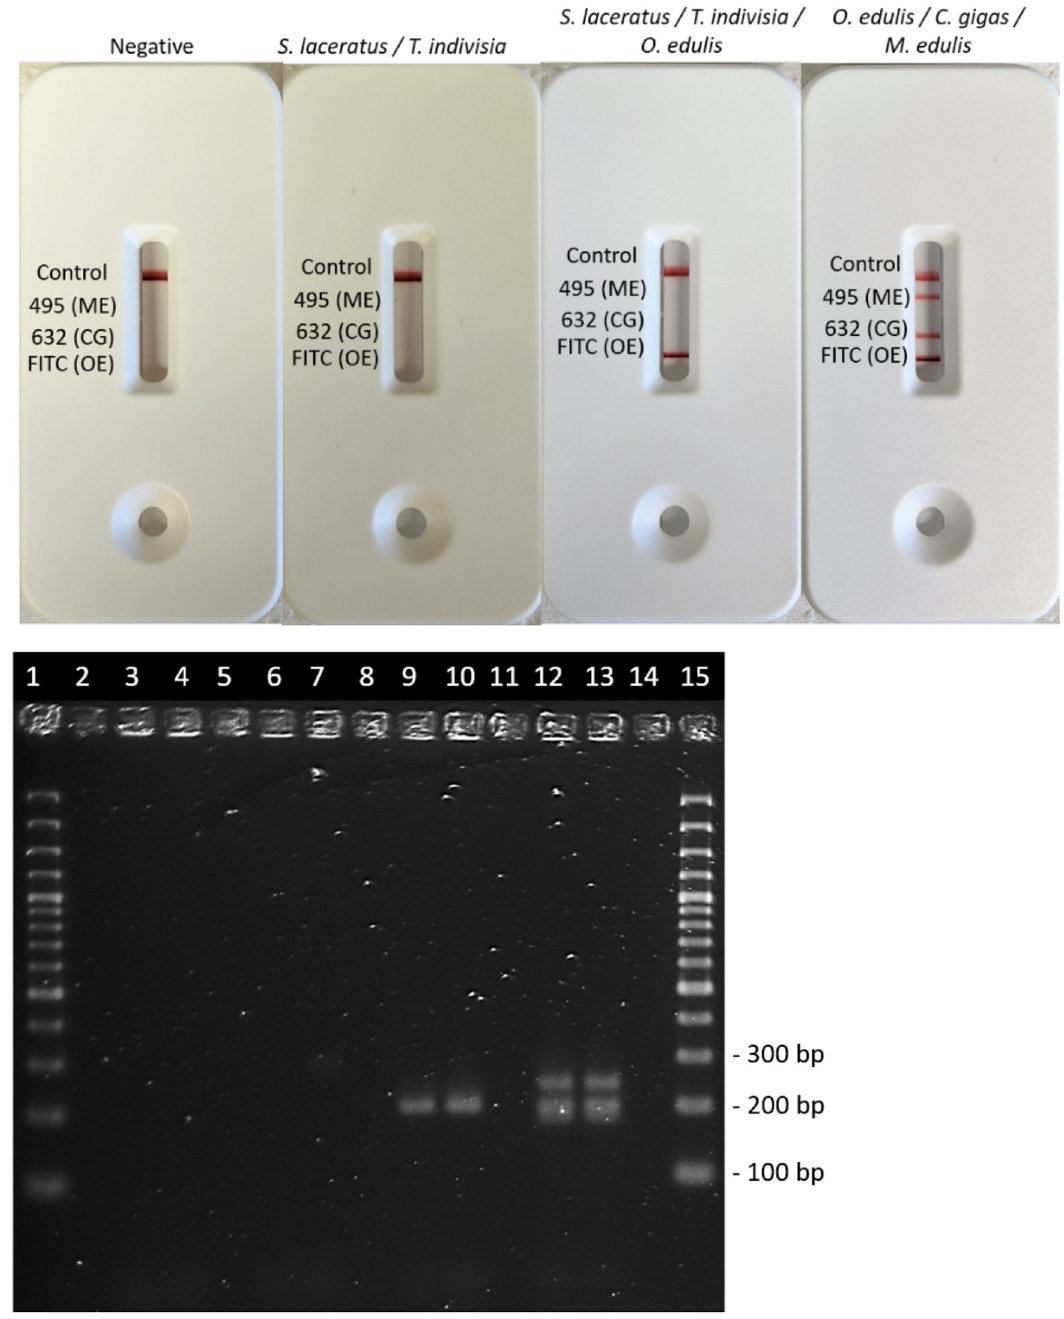
Fig. 7. PCR-nucleic acid lateral fl ow immunoassay (NALFIA) with multiplex primers for Ostrea edulis, Crassostrea gigas , and Mytilus edulis . The label on the left side of every pair of cartridges is indicating the test line for the existence of O. edulis (FITC OE), C. gigas (632 CG), and M. edulis (495 ME). The most upper line on the cartridges is indicating the control line of each NALFIA. The NALFIA was tested with DNA templates in the combination of Sagartiogeton laceratus / Tubularia indivisa, S. laceratus / T. indivisa / O. edulis, and O. edulis / C. gigas / M. edulis . The image of the 3% agarose gel electrophoresis is showing the quality control of the NALFIA. The scheme of the gel slots: 1: 100 bp marker, 2: empty, 3: OE / CG / ME x non-template replicate 1, 4: OE / CG / ME x non-template replicate 2, 5: empty, 6: OE / CG / ME x S. laceratus / T. indivisa replicate 1, 7: OE / CG / ME x S. laceratus / T. indivisa replicate 2, 8: empty, 9: OE / CG / ME x S. laceratus / T. indivisa / O. edulis replicate 1, 10: OE / CG / ME x S. laceratus / T. indivisa / O. edulis replicate 2, 11: empty, 12: OE / CG / ME x O. edulis / C. gigas / M. edulis replicate 1, 13: OE / CG / ME x O. edulis / C. gigas / M. edulis 2, 14: empty, 15: 100 bp